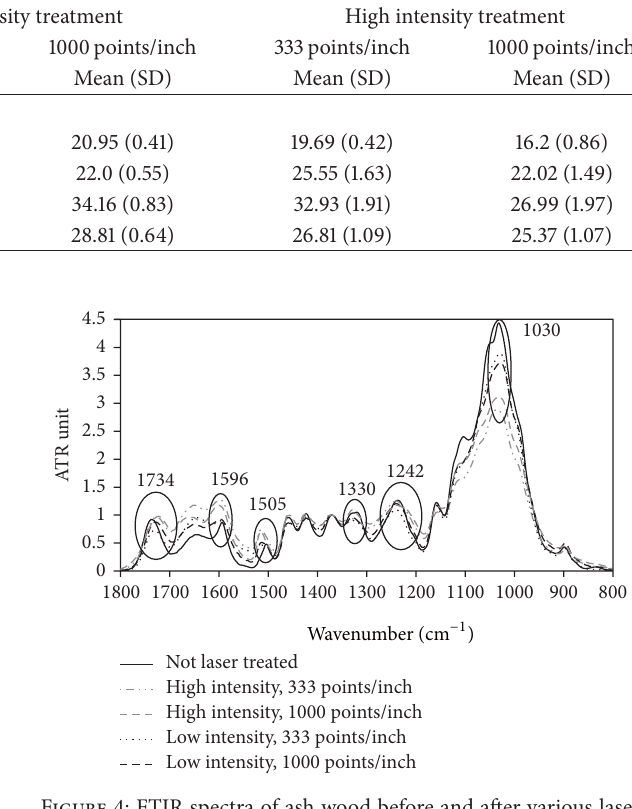
Figure 4: FTIR spectra of ash wood before and after various laser beam